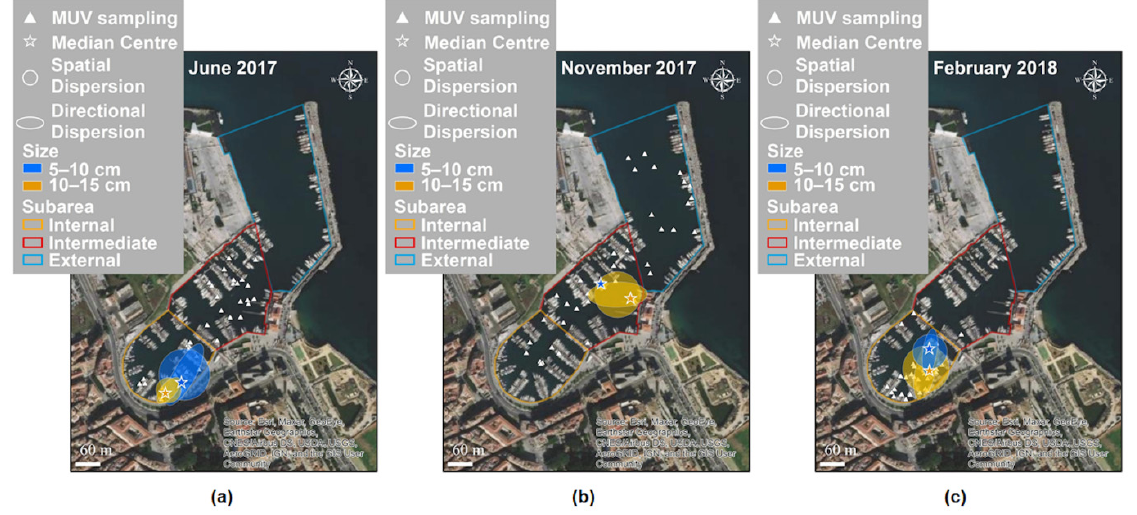
Figure 9. Key characteristics of the distribution of Cassiopea andromeda in Cala in ( a ) June 2017, ( b )